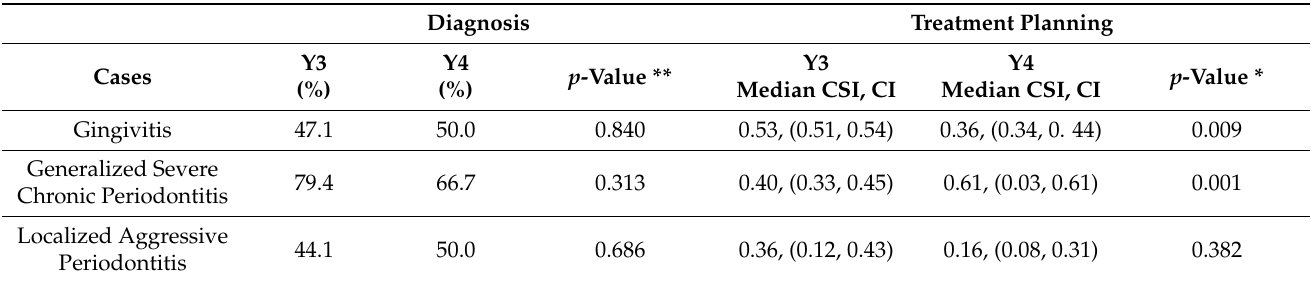
Table 2. Diagnosis and treatment planning of the three clinical